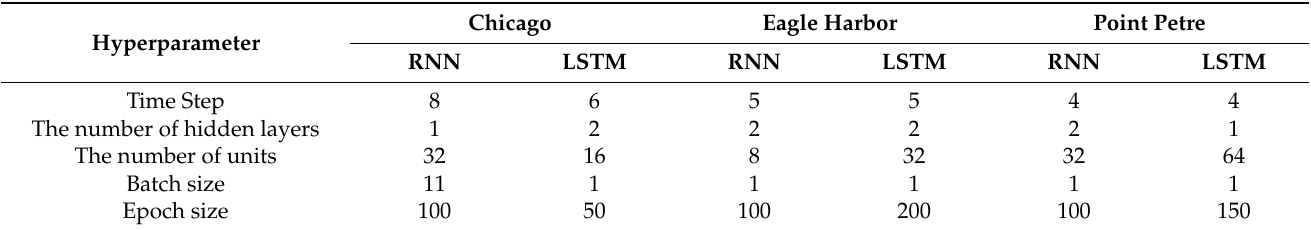
Table 4. The optimal hyperparameter combination of RNN and LSTM model on three